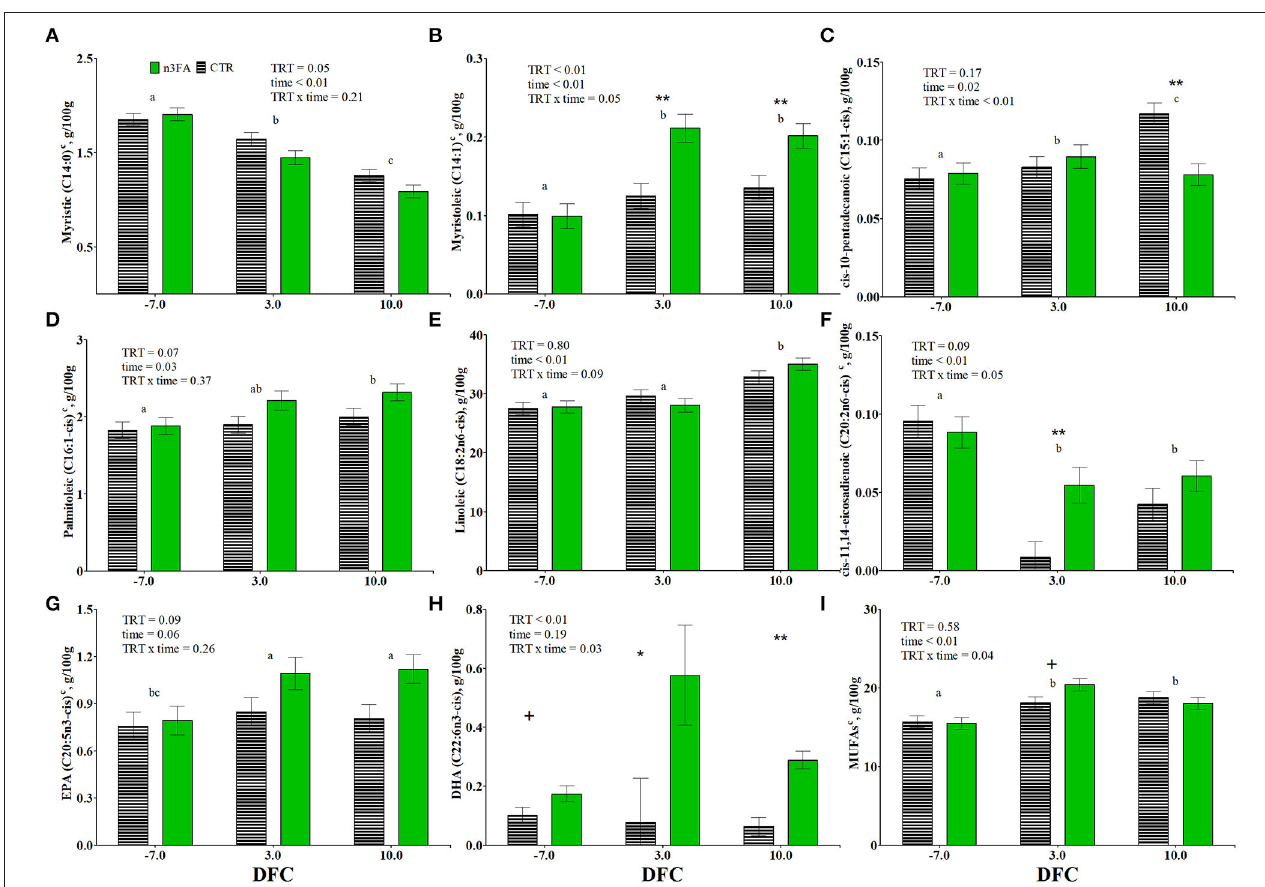
FIGURE 3 | Time course of plasma relative abundances of myristic acid (C14:0; A ), myristoleic acid (C14:1; B ), cis-10-pentadecanoic acid (C15:1-cis; C ), palmitoleic acid (C16:1-cis; D ), linoleic acid (C18:2n6-cis; E ), cis-11,14-eicosadienoic acid (C20:2n6-cis; F ), eicosapentaenoic acid (C20:5n3-cis; G ), docosahexaenoic acid (C22:6n3-cis; H ), and total monounsaturated fatty acids (MUFAs; I ) in dairy cows infused with 150ml of sterile saline (CTR; black dotted line) or 150ml of a 10% solution containing purified fish oil rich in long-chained omega-3 fatty acids (n3FA; solid green line) at 12, 24, and 48h after calving. TRT is treatment effect; time is time effect (a, b, c signify differences between time points at P < 0.05. Time points having the same letters are equal), TRT × time is treatment × time interaction effect (** is P < 0.1; * is P < 0.05; + is P < 0.10), c parameter was covariate on − 3 DFC value.